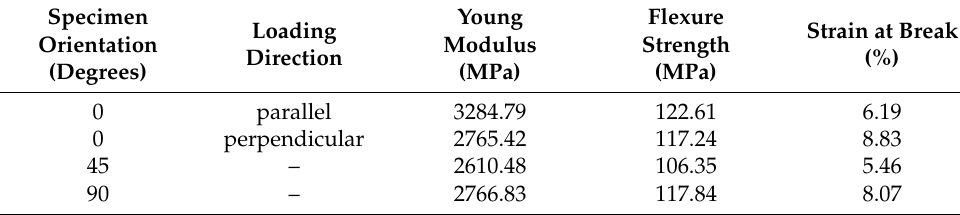
Table 1. Flexure test results for NEXTDENT.